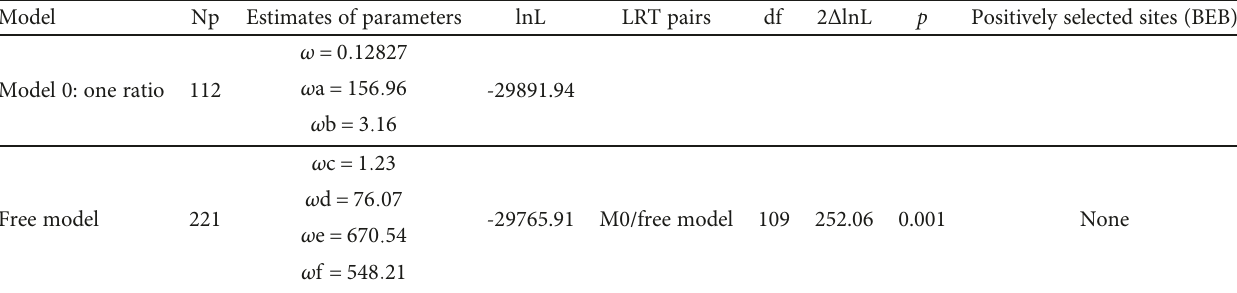
Table 3: Parameter estimation and likelihood ratio tests for the branch